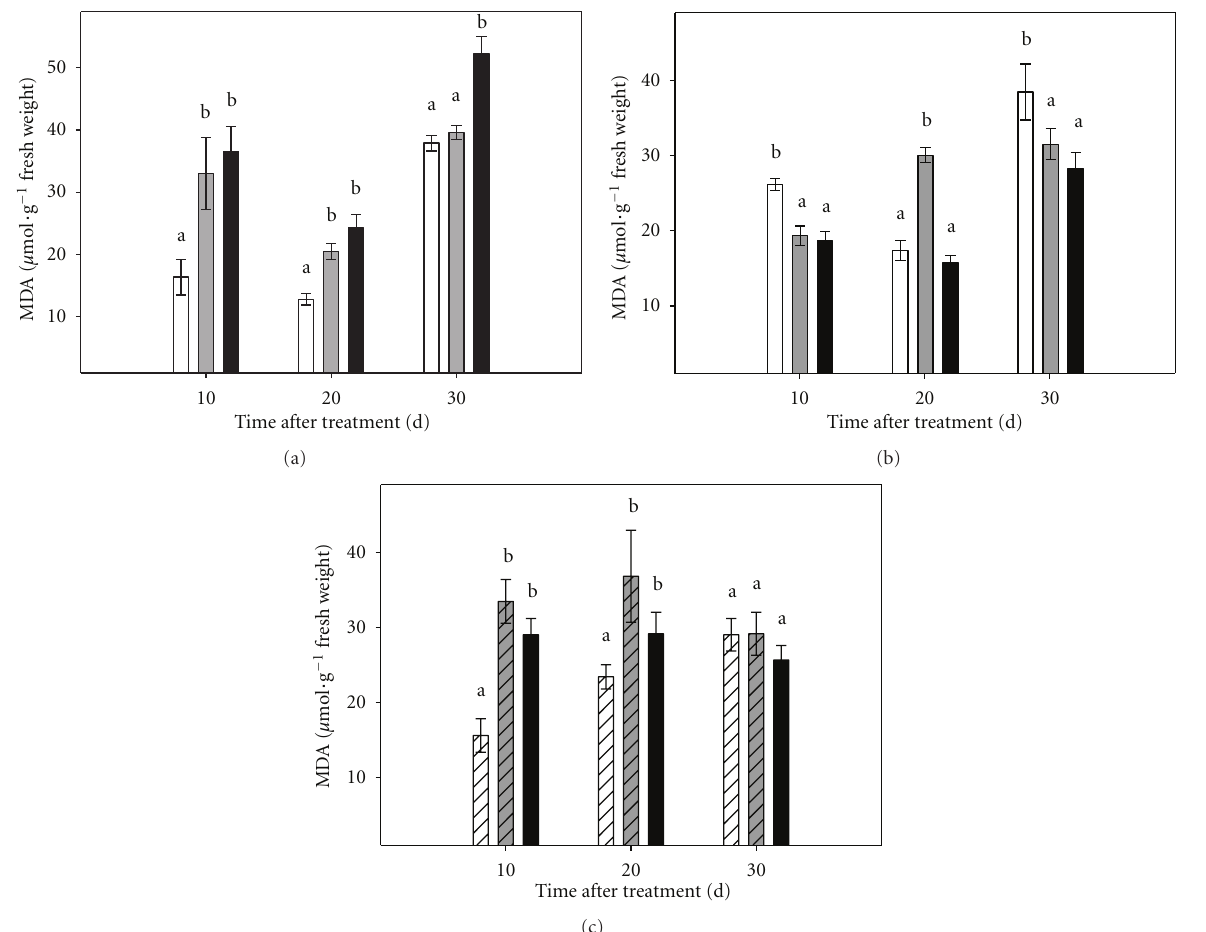
Figure 3: E ff ect of osmotic stress on MDA content in Carrizo citrange cultured in vitro . (a): aerial part of intact plants; (b): root tissue of intact plants; (c): micropropagated shoots. Control plants (white bar), plants cultured under moderate (grey bar) or severe (black bar) osmotic stress conditions. Each point corresponds to the average ± standard error of six independent determinations. Di ff erent letters denote statistical significance at P < 0.05.